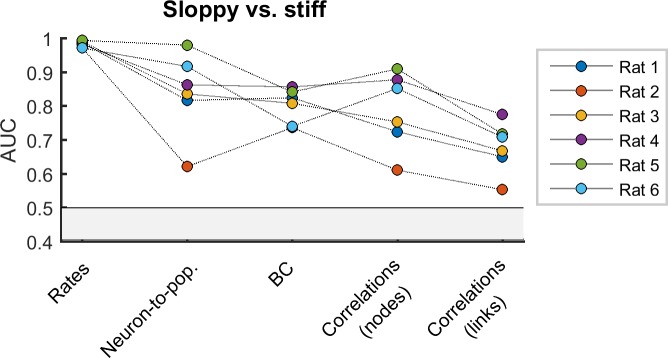
Alternative definition of sensitivity.Area under the receiver operating curve (AUC) quantifying the separation of distributions of sloppy and stiff classes using the weighted sensitivity sw defined using equation 9. All AUC values were significantly higher than 0.5 (p < 0.001).